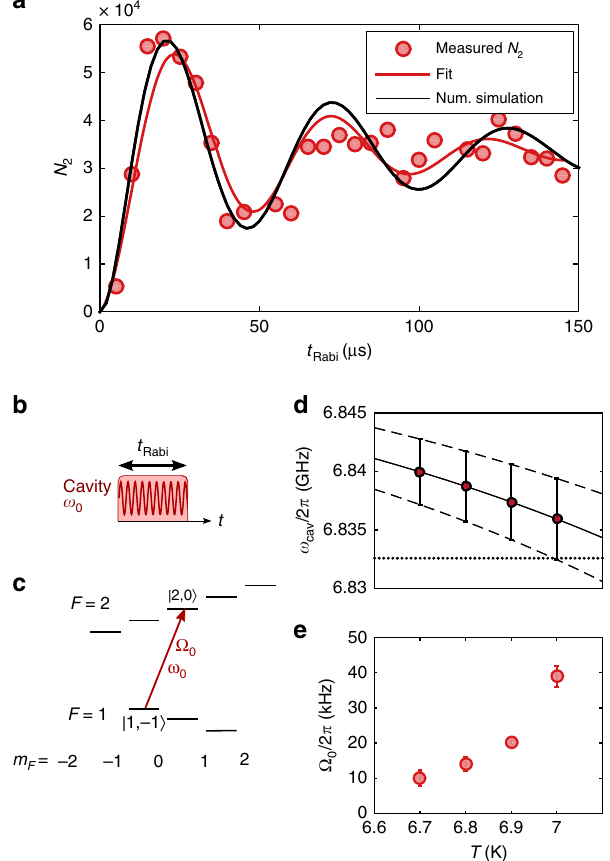
Fig. 3 Cavity-driven Rabi oscillations. a Measurement of the atoms in state | 2, 0 〉 reveals resonant Rabi oscillations between | 1, − 1 〉 and | 2, 0 〉 for a cavity-driving frequency of ω 0 = 2 π · 6.83242 GHz. The chip temperature was set to T = 6.9 K. The red solid line is a fi t to the damped oscillation, and the black line shows the result of the numerical simulations. b Timing sequence and c level scheme for the driven one-photon Rabi oscillations. d Temperature dependence of the cavity resonance frequency. The circles and error bars indicate the peak and the width ( ± κ ) of the cavity line obtained from fi ts to the resonator transmission data. The solid and dashed lines indicate the fi tted temperature dependence of the cavity frequency and linewidth (Supplementary Note 3 for details). The horizontal dotted line indicates the driving frequency, corresponding to the atomic resonance. e Temperature dependence of the Rabi frequency. While the cavity is driven at the same frequency ω 0 for all measurements, the temperature dependence of the cavity resonance leads to a change in the microwave intensity. Error bars indicate the con fi dence interval of the Rabi frequency